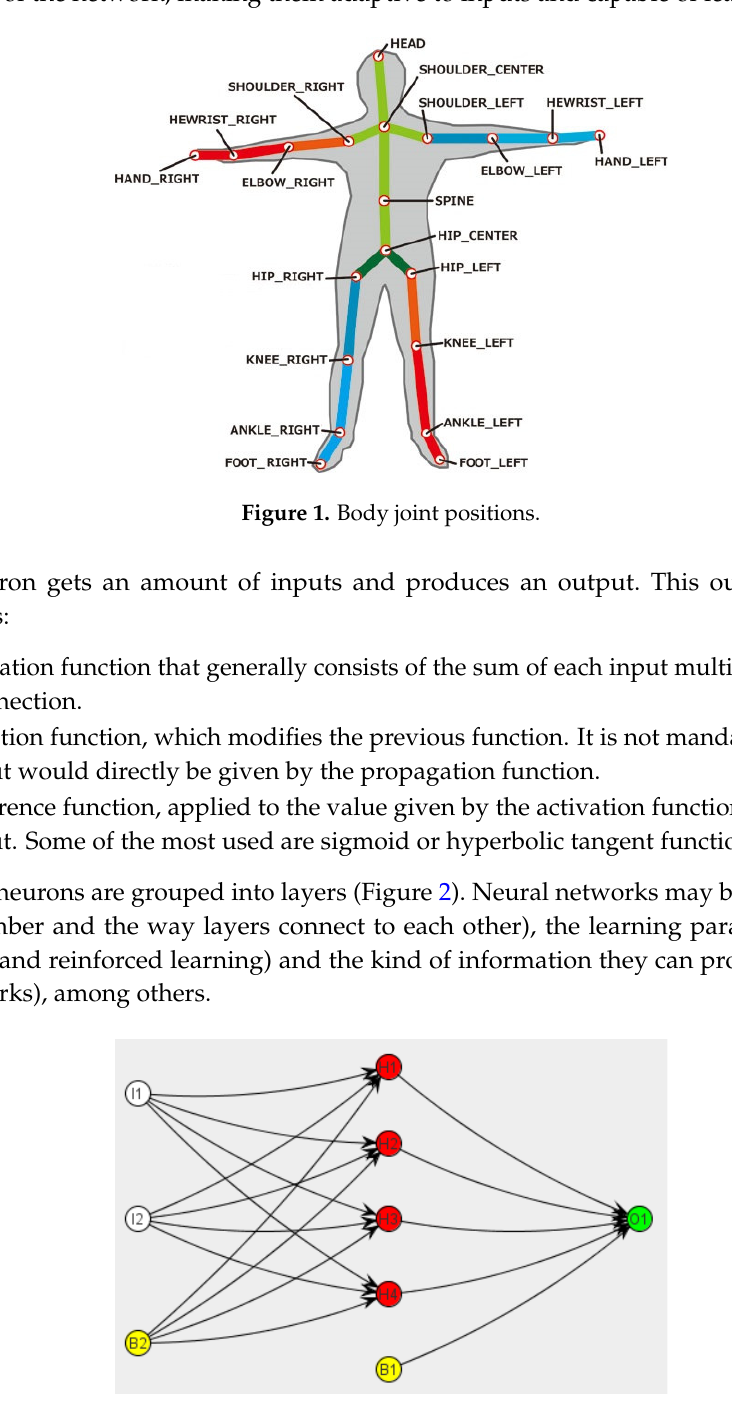
Figure 2. Example of artificial neurons grouped into